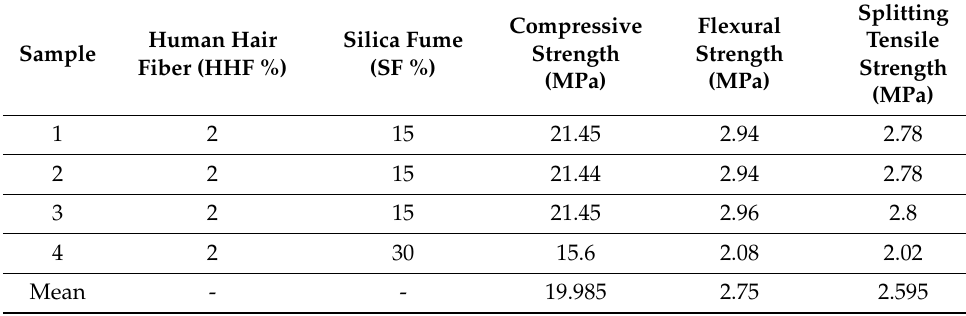
Table 8. Summary of Optimization